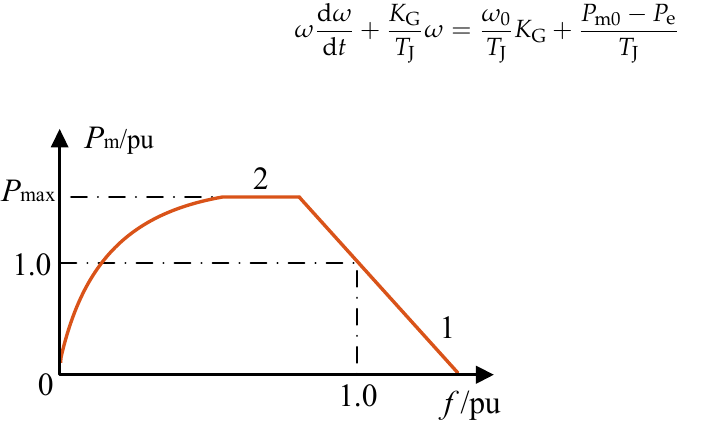
Figure 14. Simplified power–frequency characteristic.